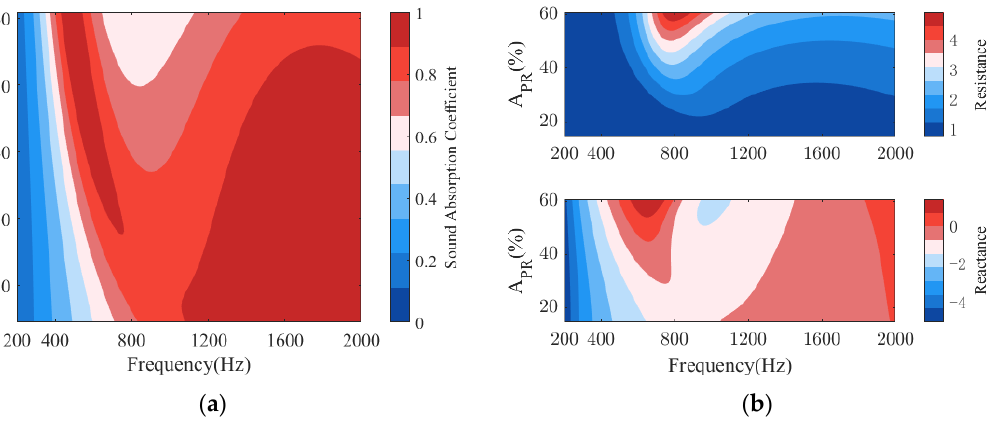
Figure 9. Effects of the area occupancy ratio A PR of PR on the sound absorption of PPCS: ( a ) sound absorption coefficients; ( b ) normalized surface acoustic impedance.